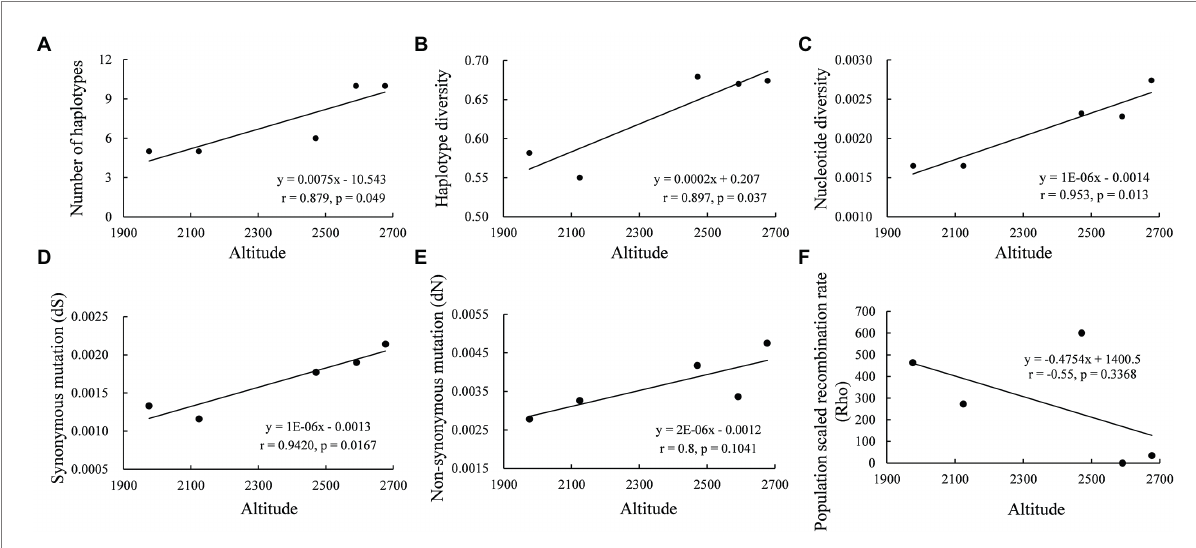
FIGURE 3 Correlations between the altitude of the collection sites of the pathogen and the genetic variation of Pi02860 gene: (A) the number of haplotypes; (B) haplotype diversity; (C) nucleotide diversity; (D) synonymous mutation; (E) nonsynonymous mutation; (F) population scaled recombination rate of Pi02860 and